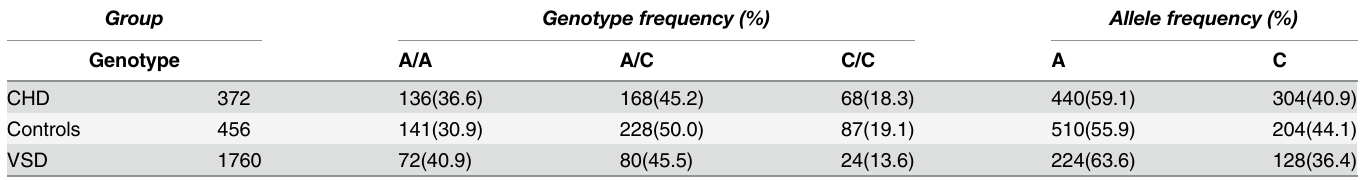
Table 2. The genotype and allele frequency of SNP rs2289263 in 372 CHD patients, 176 VSD patients and 456 non-CHD controls.